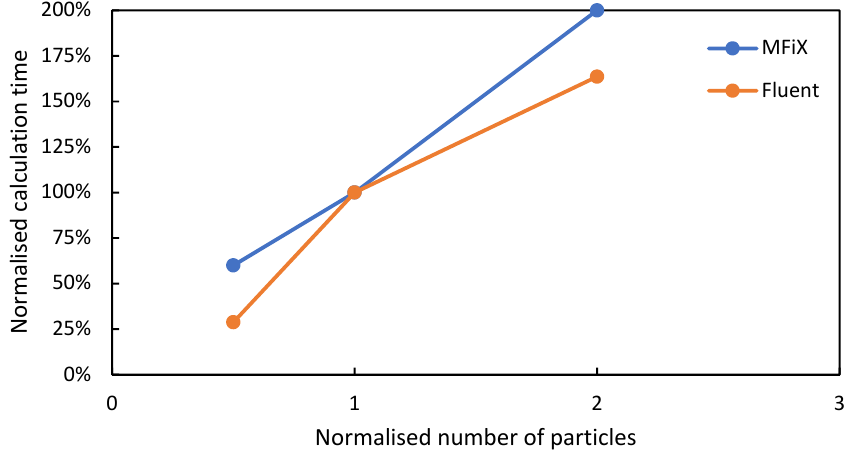
Figure 8. Normalised calculation time upon varying the total number of particles.